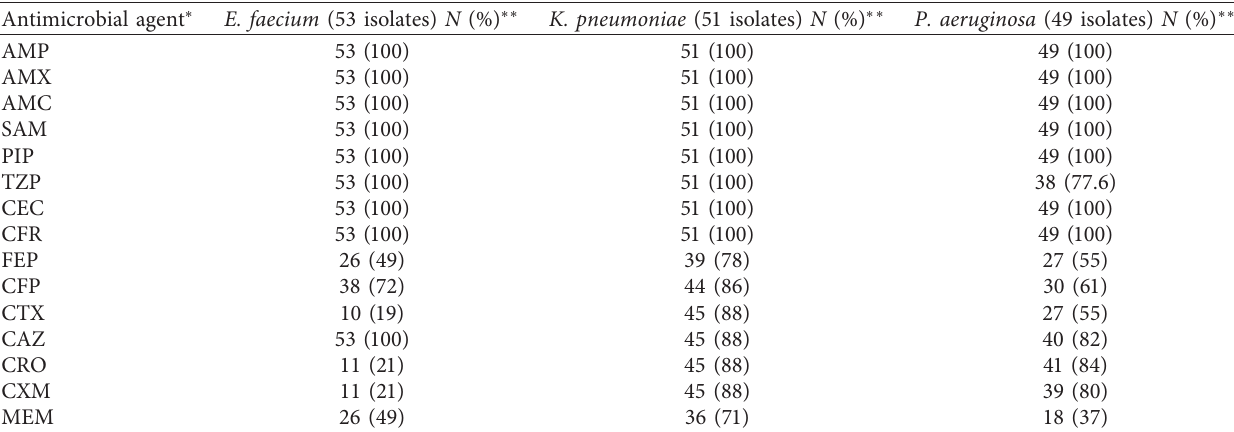
Table 2: Antimicrobial resistance patterns of isolates included in this study. Antimicrobial agent ∗